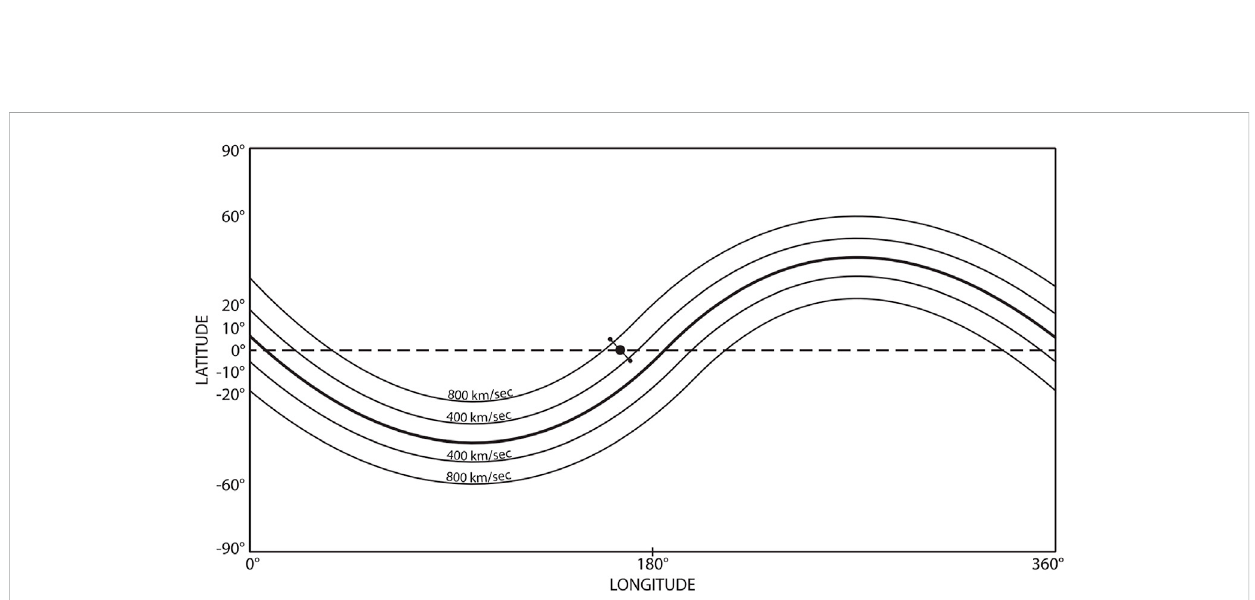
FIGURE 8 The wind speed distributionfor an average active period on the Carrington map, by making the magneticequator quasi-sinusoidal. The gap may be wider during active periods.